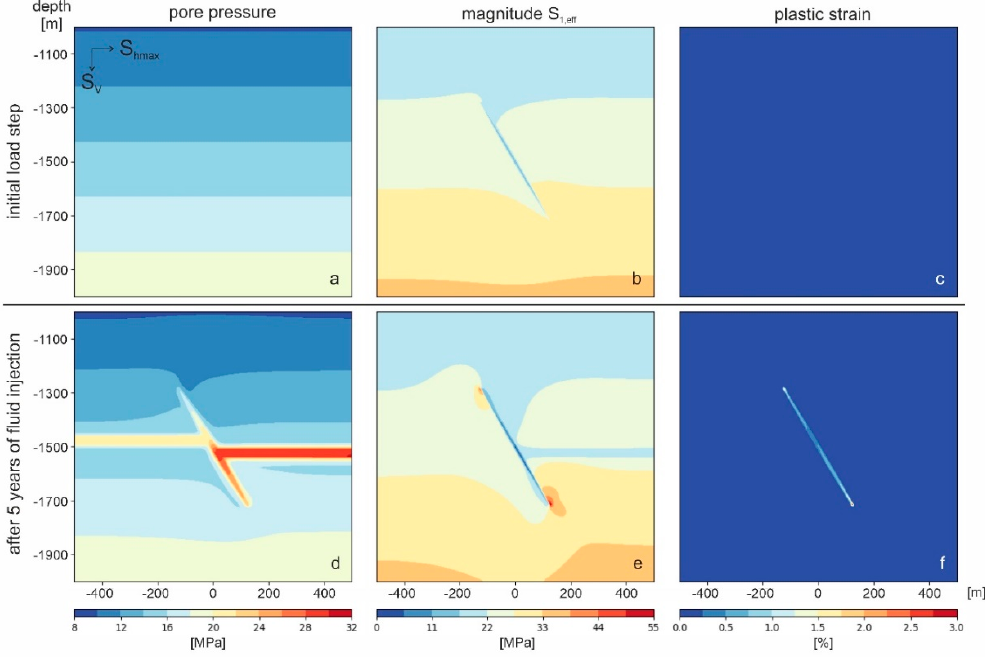
Figure 5. Some simulation results for the reference model (C3-60) with a curvilinear grid adapted to a fault with 60° dip and 3-element width. ( a – c ) show the spatial variation in pore pressure ( a ), magnitude of the effective maximum principal stress (S 1,eff ); ( b ) and total von Mises plastic strain ( c ) for the initial state, i.e., prior to fluid injection. ( d – f ) show the corresponding simulation results after 5 years of injection and a pore pressure increase in the lower reservoir horizon of 15 MPa, respectively.